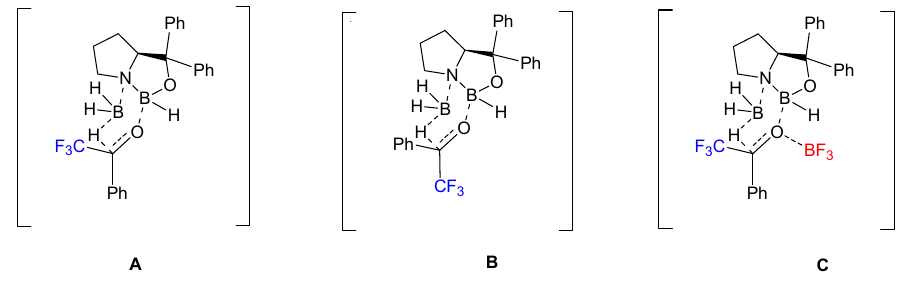
Figure 5. Proposed transition state models.